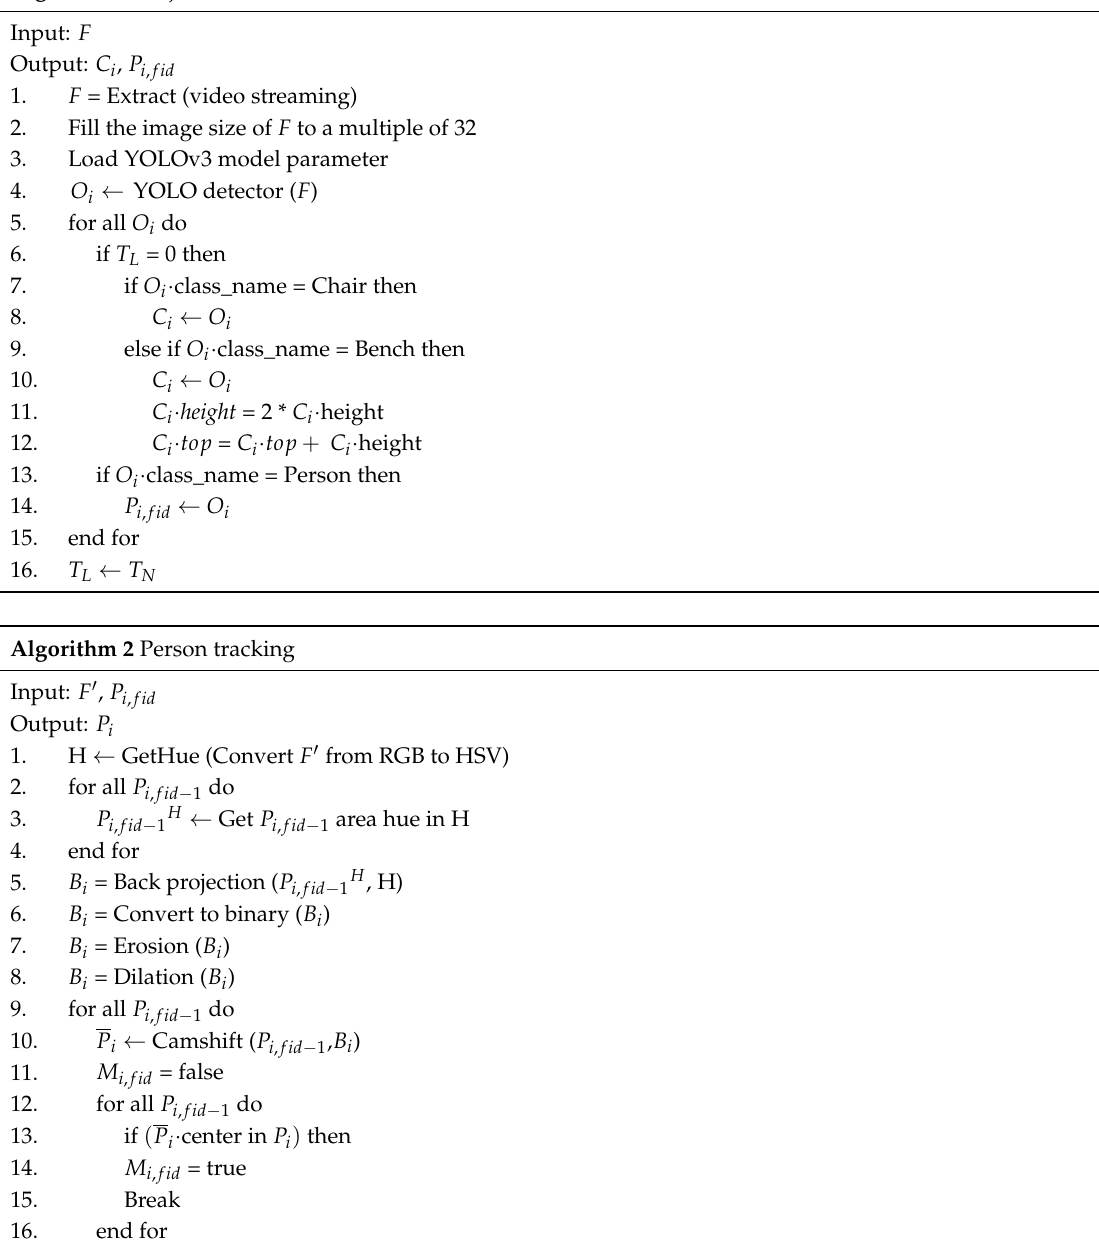
Algorithm 1 Object detection